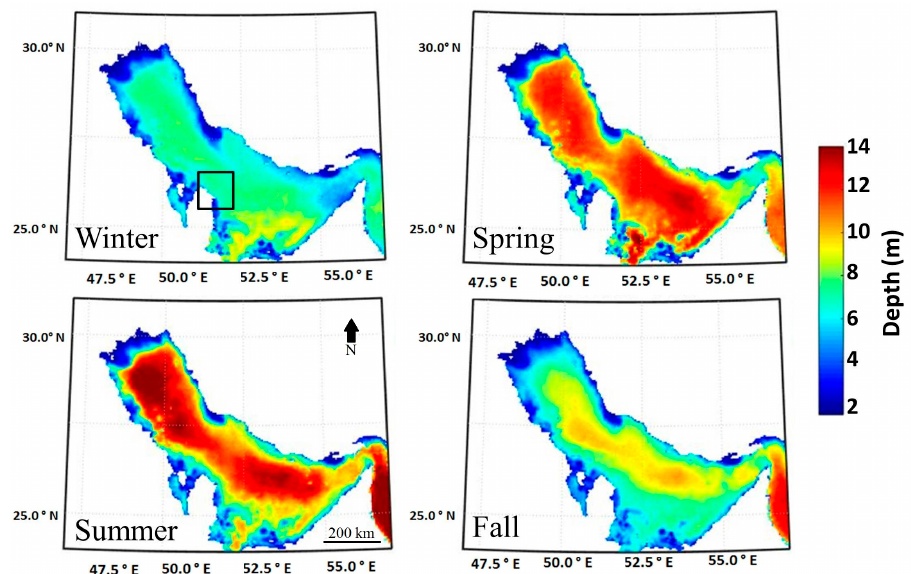
Figure 5. Seasonal climatologies of OC-CCI first optical depth data (m) at Arabian Gulf . The presented data are computed from the monthly averaged OC-CCI diffuse attenuation coefficient K d (490) over the period 1998-2013. The black box indicates the study area.